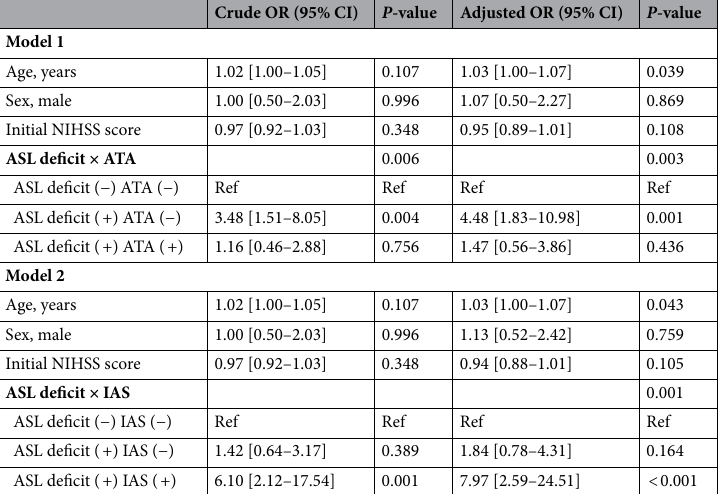
Table 3. Multivariable logistic regression analyses of possible predictors for ERIL, considering the interactive effects between ASL perfusion deficit and ATA/IAS. ERIL early recurrent ischemic lesion, ASL arterial spin labeling, ATA arterial transit artifact, IAS intraarterial high-intensity signal, NIHSS National Institutes of Health Stroke